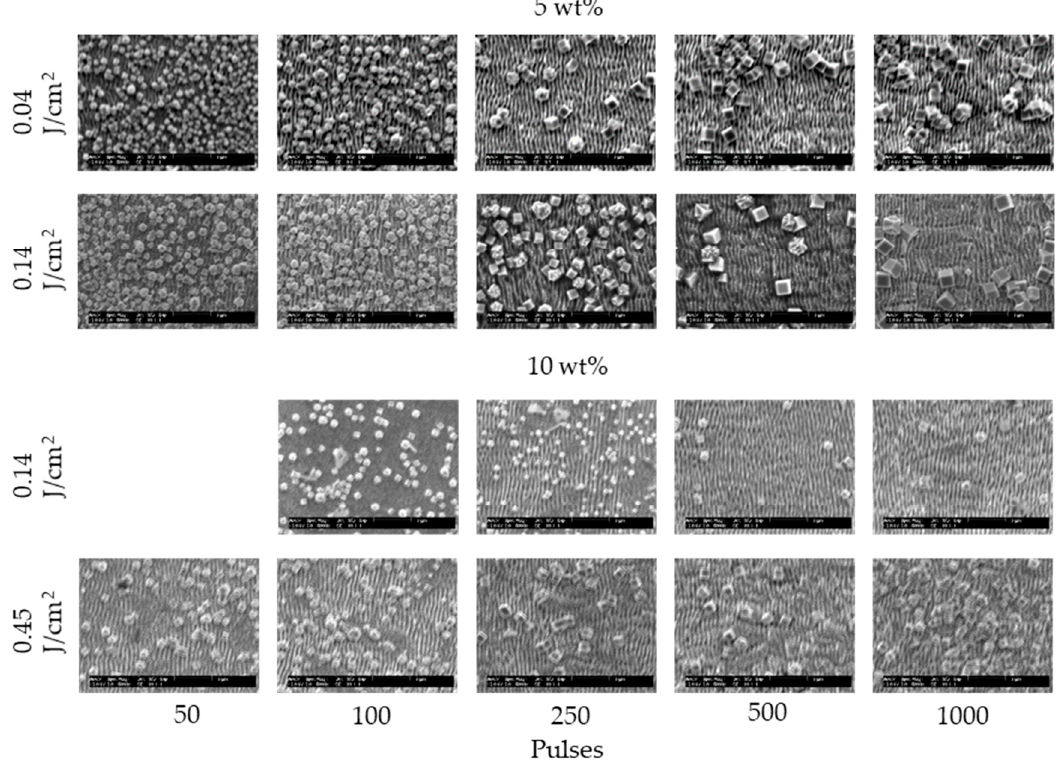
Figure 6. SEM images of 304 stainless steel irradiated with N = 50–1000 pulses at F = 0.04–0.45 J/cm 2 in 5 and 10 wt% Cu(NO 3 ) 2 solutions. The laser beam has the polarization in a lateral direction.